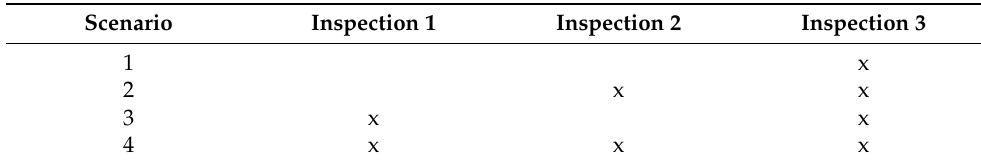
Table 2. List of the selected simulated